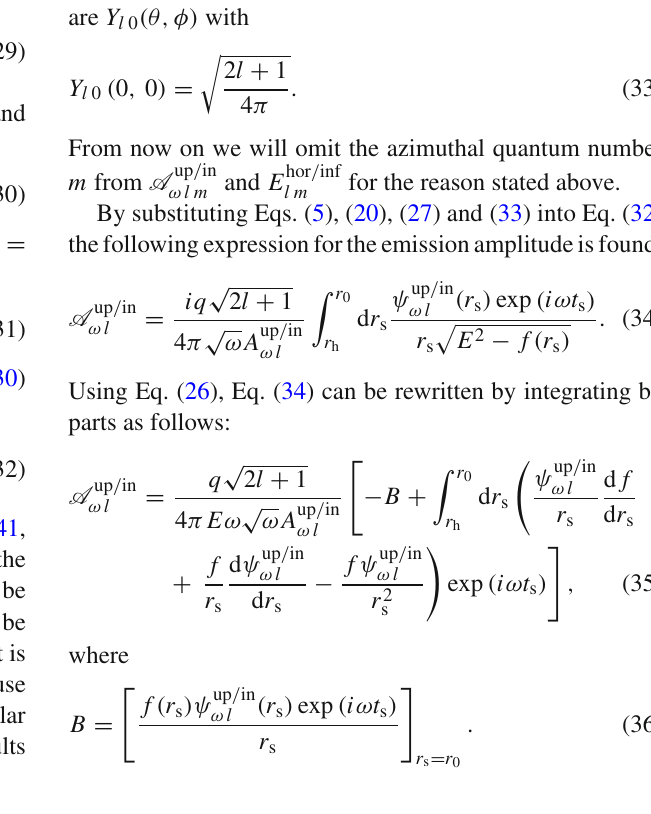
j ( x μ ) minimally coupled to a scalar field